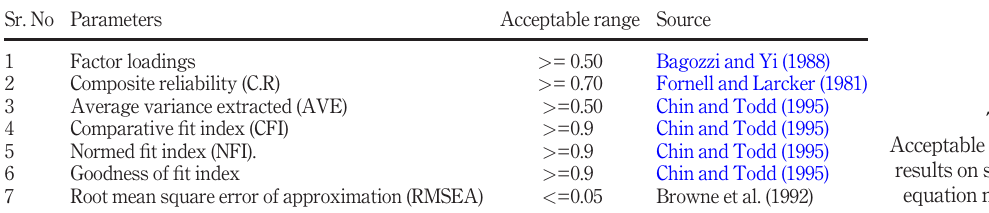
Table 5. Acceptable range for